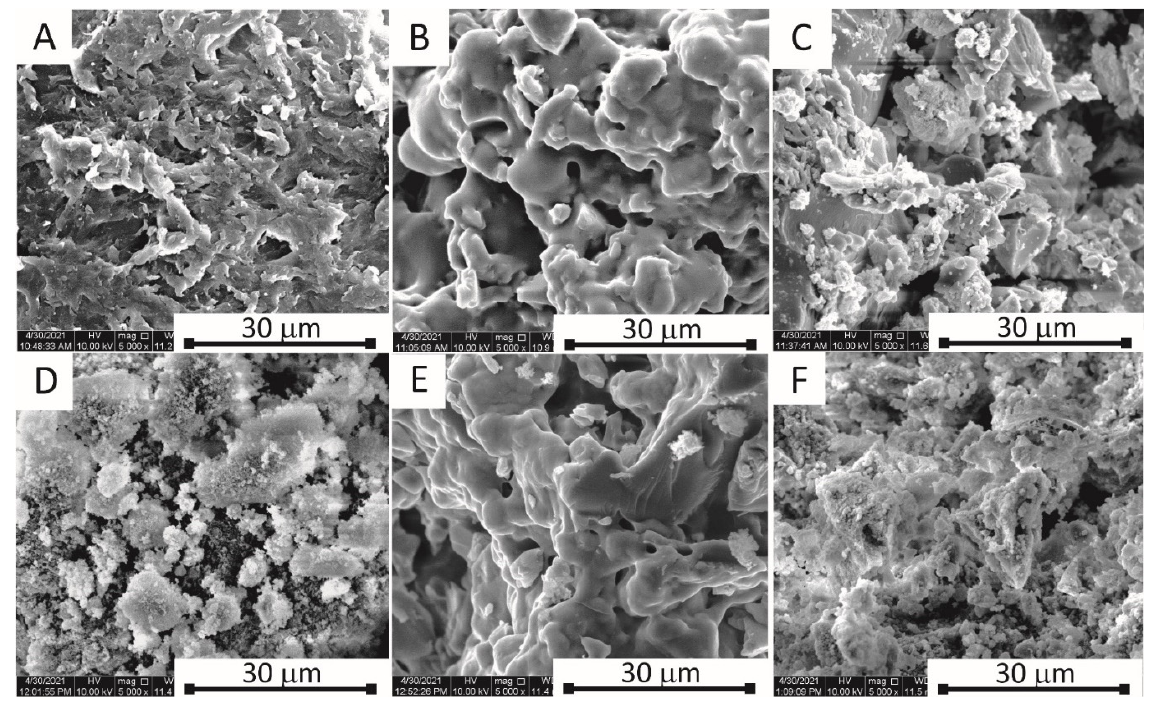
Figure 3. SEM images of ( A ) [P(EMA)- co -(GMA)], ( B ) [P(EMA)- co -(GMA)]-ETA( 1 ), ( C ) [P(EMA)- co -(GMA)]-Orn( 1 ), ( D ) [P(EMA)- co -(GMA)]-Xyl, ( E ) [P(EMA)- co -(GMA)]-ETA( 2 ), and ( F ) [P(EMA)- co -(GMA)]-Orn( 2 ).